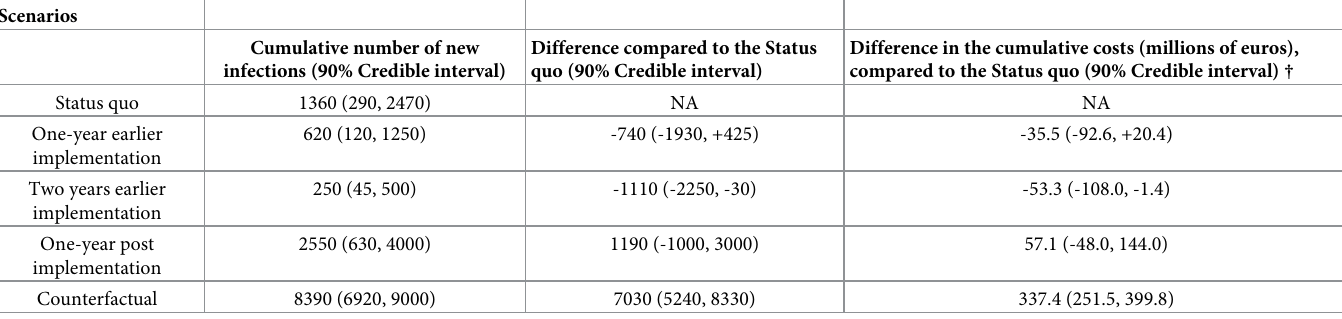
Table 2. Cumulative number of infections and cumulative costs among people who inject drugs during four different scenarios, compared to the status quo sce- nario. Ranges in the brackets correspond to the 90% credibility intervals.